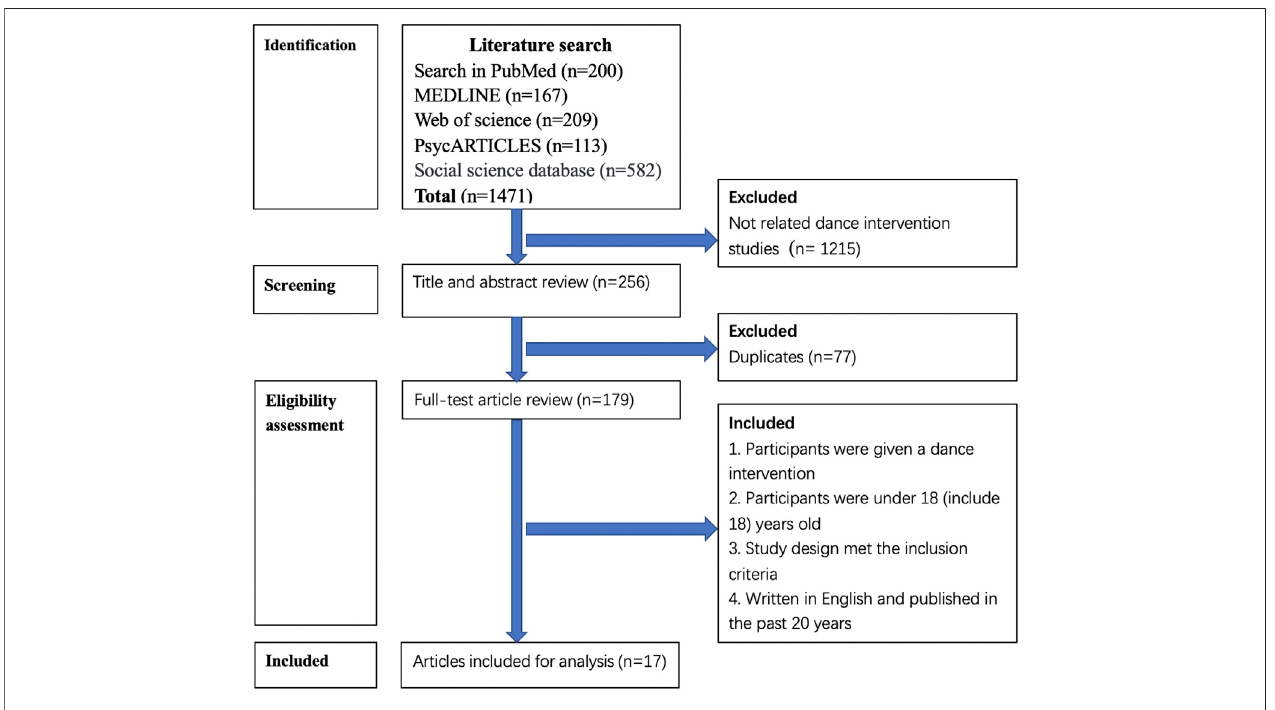
FIGURE 1 | Flowchart: Article selection